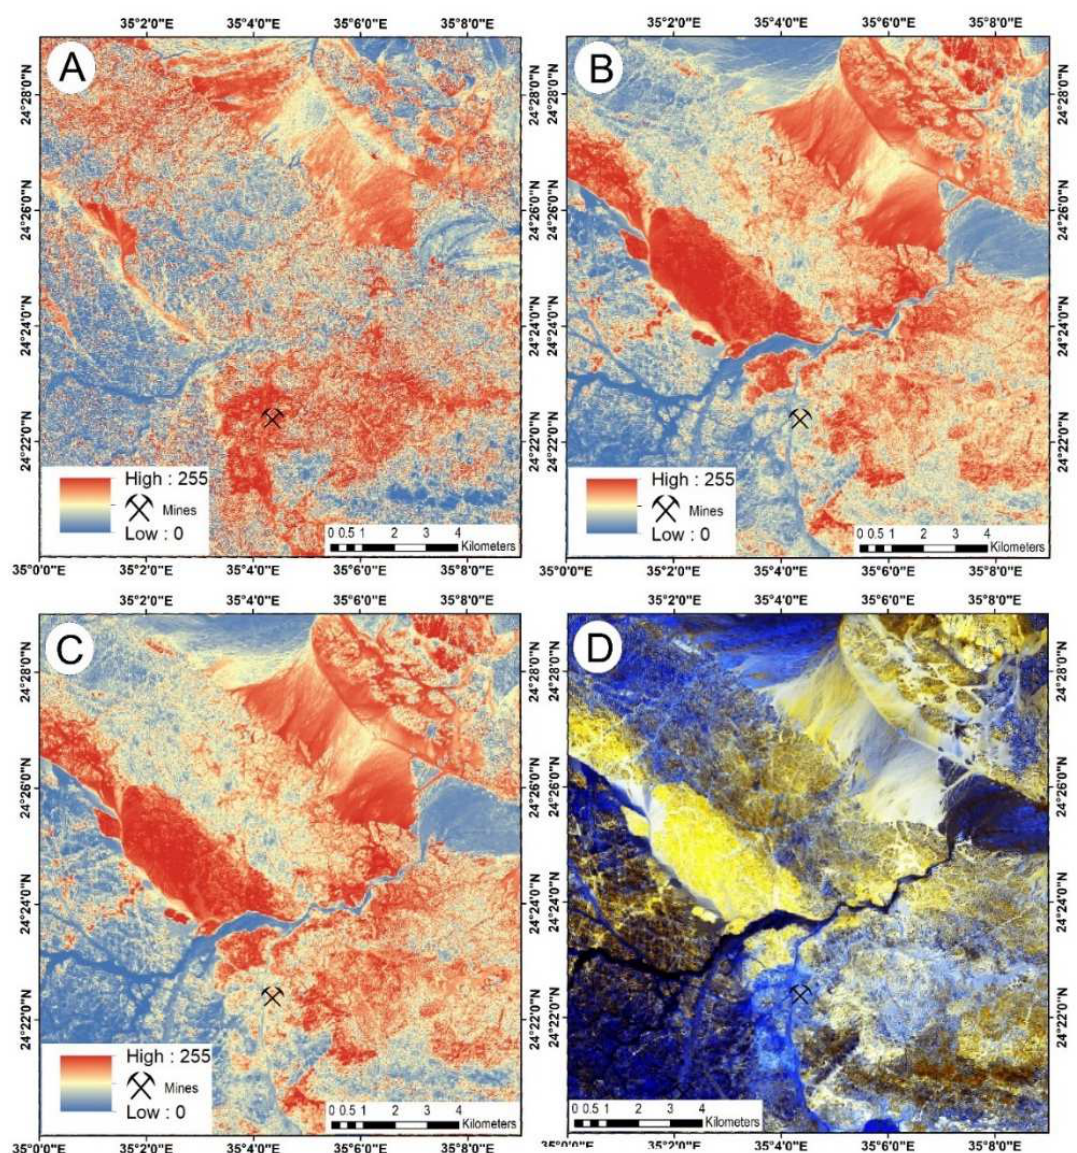
Figure 9. Principal component mapping of hydrothermal alterations: ( A ) Negated PC4 imagery for iron alteration mapping. ( B ) Negated PC3 image for clay alteration mapping. ( C ) The sum of negated PC3 and PC4 imagery. ( D ) PCA false-color composite imagery.